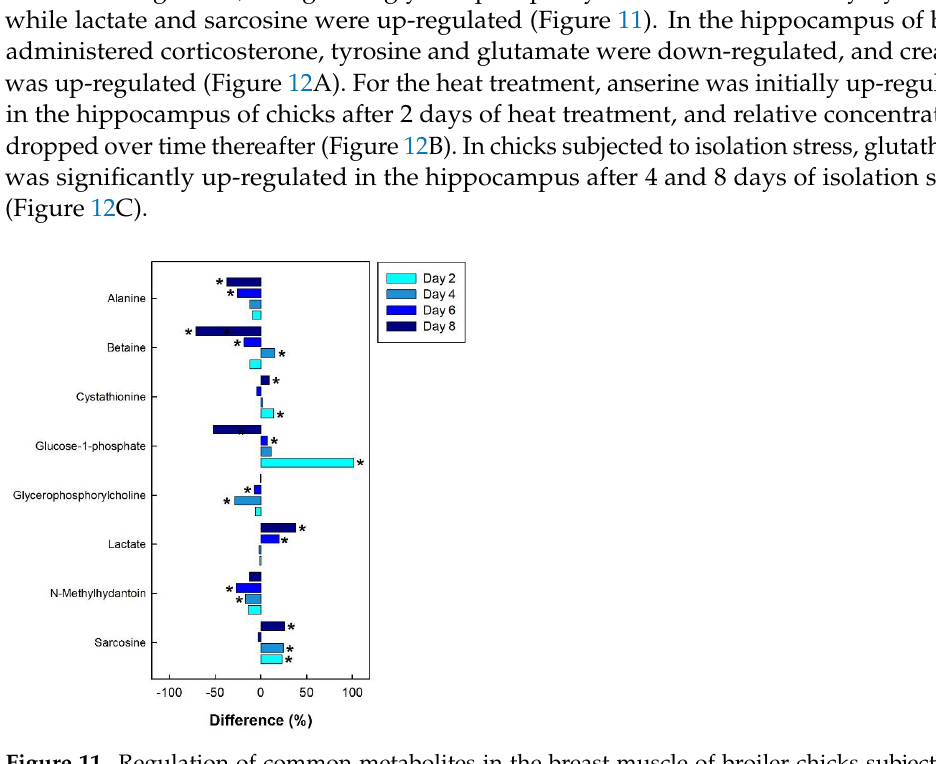
Figure 11. Regulation of common metabolites in the breast muscle of broiler chicks subjected to corticosterone-incited stress relative to the control treatment at the four experimental endpoints. Metabolites that were significantly altered ( p < 0.050) are indicated by asterisks.